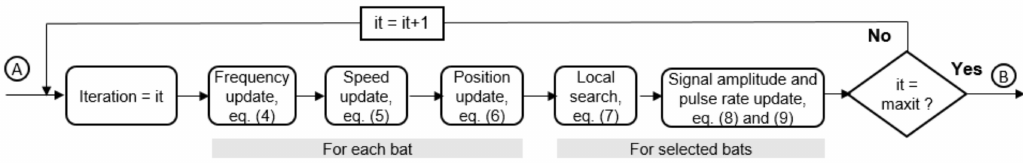
Figure 5. The flowchart of a BOA